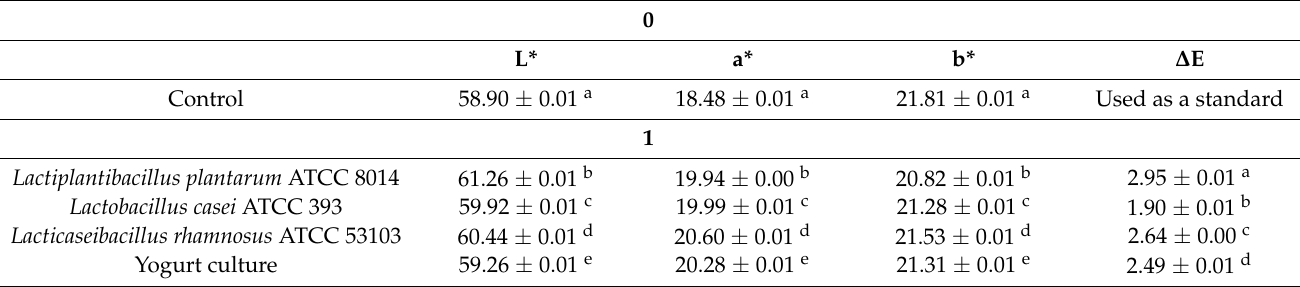
Table 4. Color changes of the